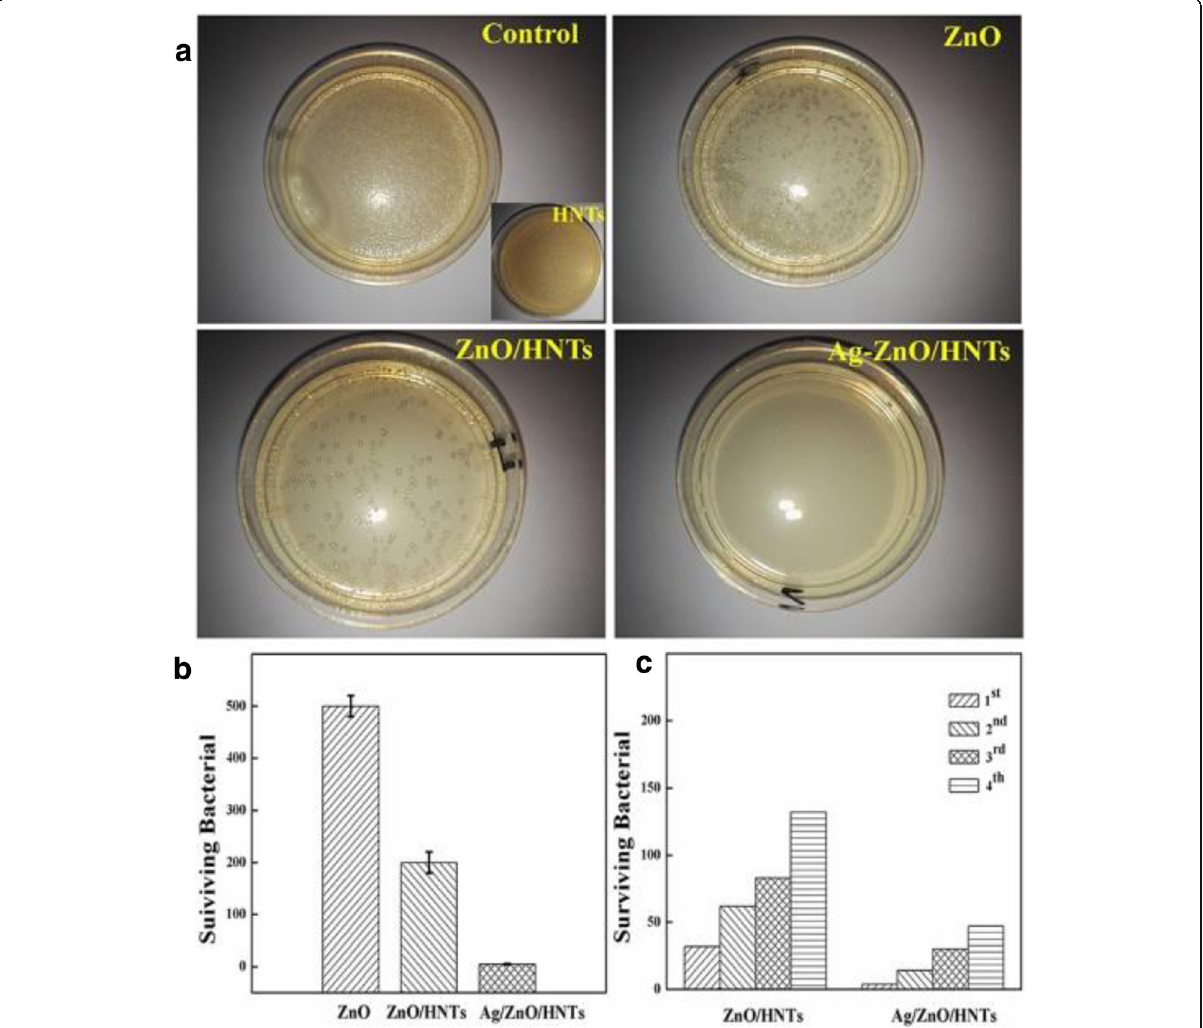
Fig. 4 a Photographs of the bacterial culture plates, b the colony forming units, and c antibacterial stability of control, ZnO, HNTs (inset), ZnO/HNTs, and Ag-ZnO/HNTs (1st, 2nd, 3rd, 4th corresponding to the reused time of nanocomposites,